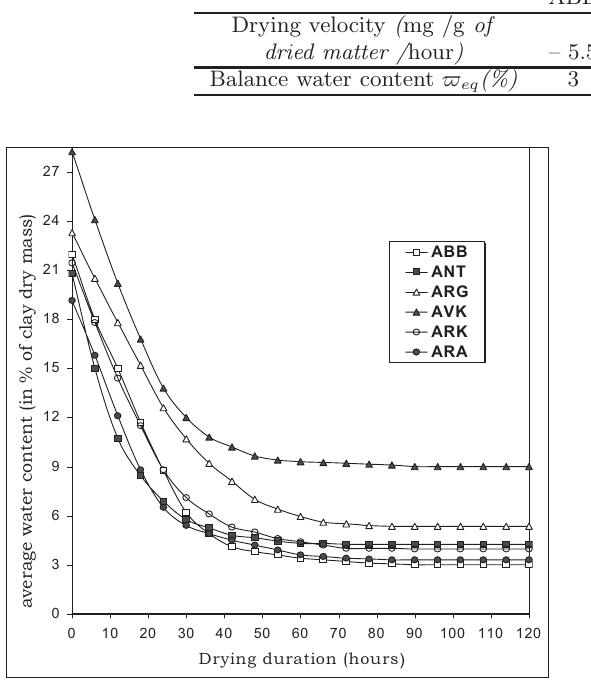
Fig. 5. Representative shrinking curves: Bigot’s curves, shrinkage